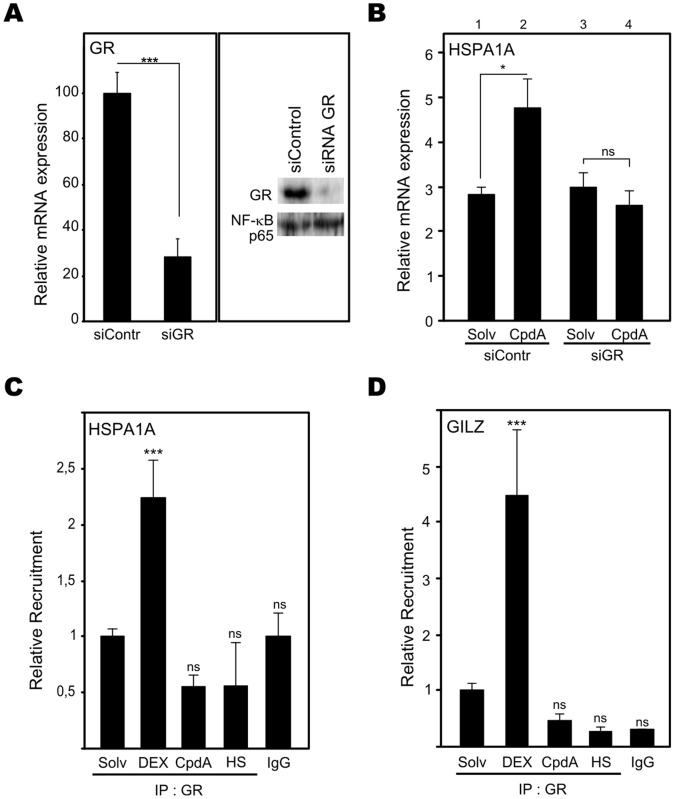
CpdA stimulation of the Hsp70 gene promoter occurs via a GR-dependent mechanism.(A) A549 cells were transfected with siControl or siRNA targeting GR (siGR). Total RNA or total protein extracts were prepared 48h post-transfection. In the left panel, purified mRNA was subjected to RT-qPCR detecting GR gene expression levels, normalized to housekeeping controls cyclophilin and 28S. For the siControl-transfected sample, signal was set at 100%. Data from SiGR-transfected cells were recalculated accordingly. Statistical analysis (unpaired t-test) was performed to show significant difference between siControl and siGR conditions (*** p<0.001). In the right panel, total cell lysates were subjected to Western blot analysis to detect GR protein, with NF-κB p65 as a loading control. (B) In parallel with (A) A549 cells were transfected with siControl or siGR. 41h post transfection, cells were induced with Solv or CpdA (10µM) for 8h. The derived purified mRNA was subjected to RT-qPCR detecting HSPA1A gene expression levels and specific results were normalized to housekeeping controls cyclophilin and 28S. The condition Solv (siControl) was set as 1 to allow ratio comparisons. Statistical analysis (ANOVA with Tukey’s multiple comparison post test) was performed for selected pair wise comparisons (ns not significant; * p<0.05). This experiment is representative for 2 independent experiments. (C) and (D) A549 cells, serum-starved for48h in 0% DMEM, were treated with Solv, Dex (1µM), CpdA (10 µM) for 2h, or exposed to a 43°C heat shock (HS) for 1h. Total cell extracts were subjected to a ChIP assay targeting GR. Ensuing, qPCR signal of immunoprecipitated HSPA1A and GILZ gene promoter fragments is presented relative to input data. Binding to rabbit IgG represents aspecific binding. Statistical analysis (ANOVA with Tukey’s multiple comparison post test) was performed to show significant difference with the Solv condition (ns not significant; *** p<0.001). This experiment is representative for 2 independent experiments.